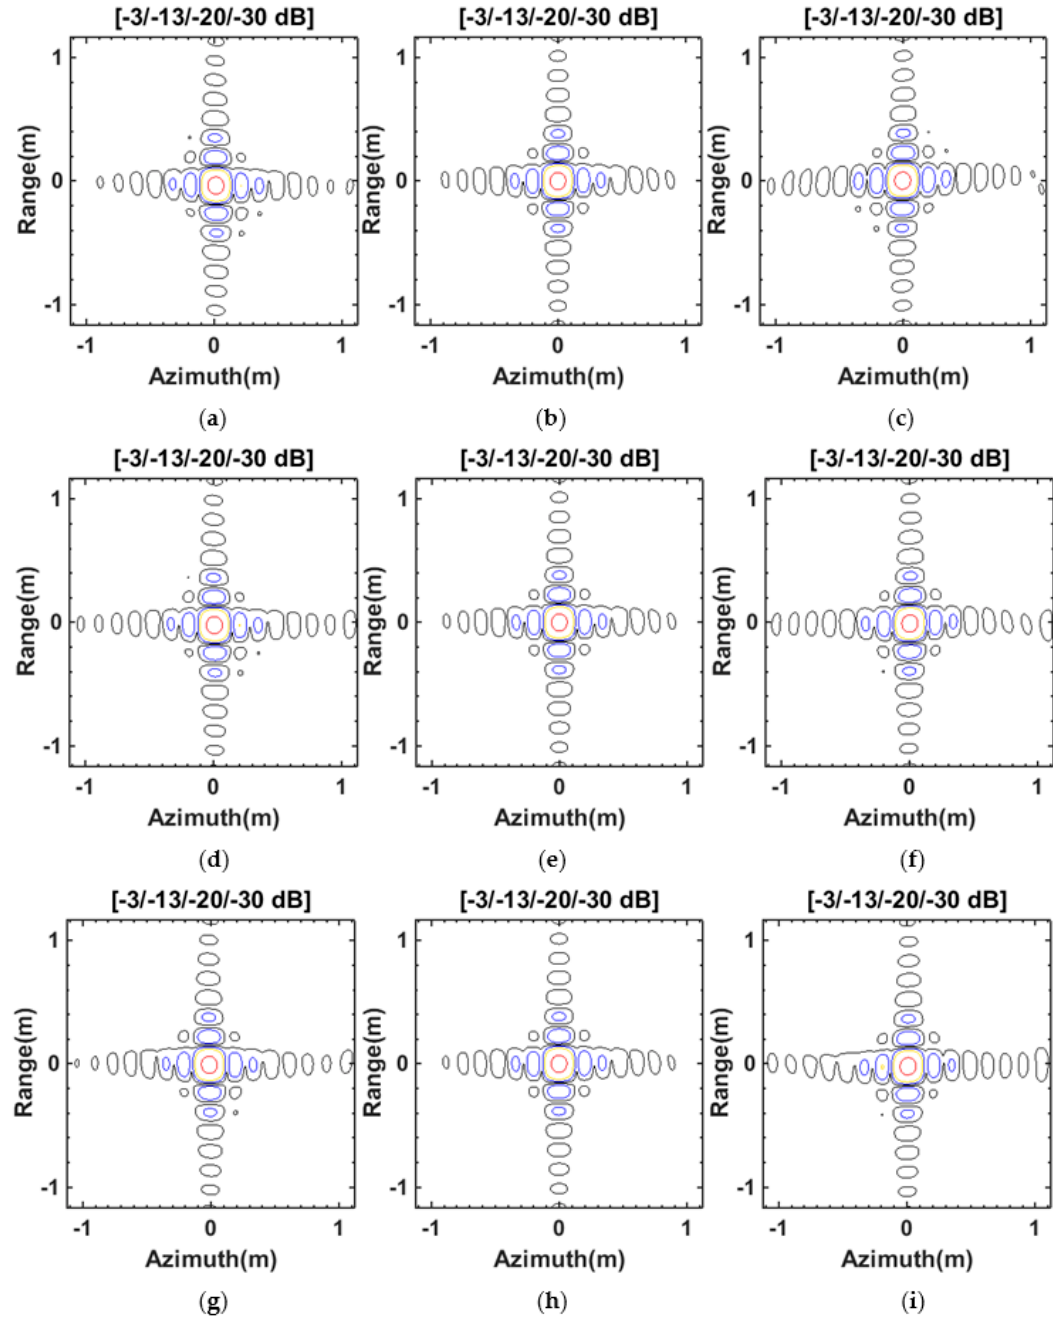
Figure 10. Imaging results with the proposed method. ( a ) Imaging result of target T 1 ; ( b ) Imaging result of target T 2 ; ( c ) Imaging result of target T 3 ; ( d ) Imaging result of target T 4 ; ( e ) Imaging result of target T 5 ; ( f ) Imaging result of target T 6 ; ( g ) Imaging result of target T 7 ; ( h ) Imaging result of target T 8 ; ( i ) Imaging result of target T 9 .